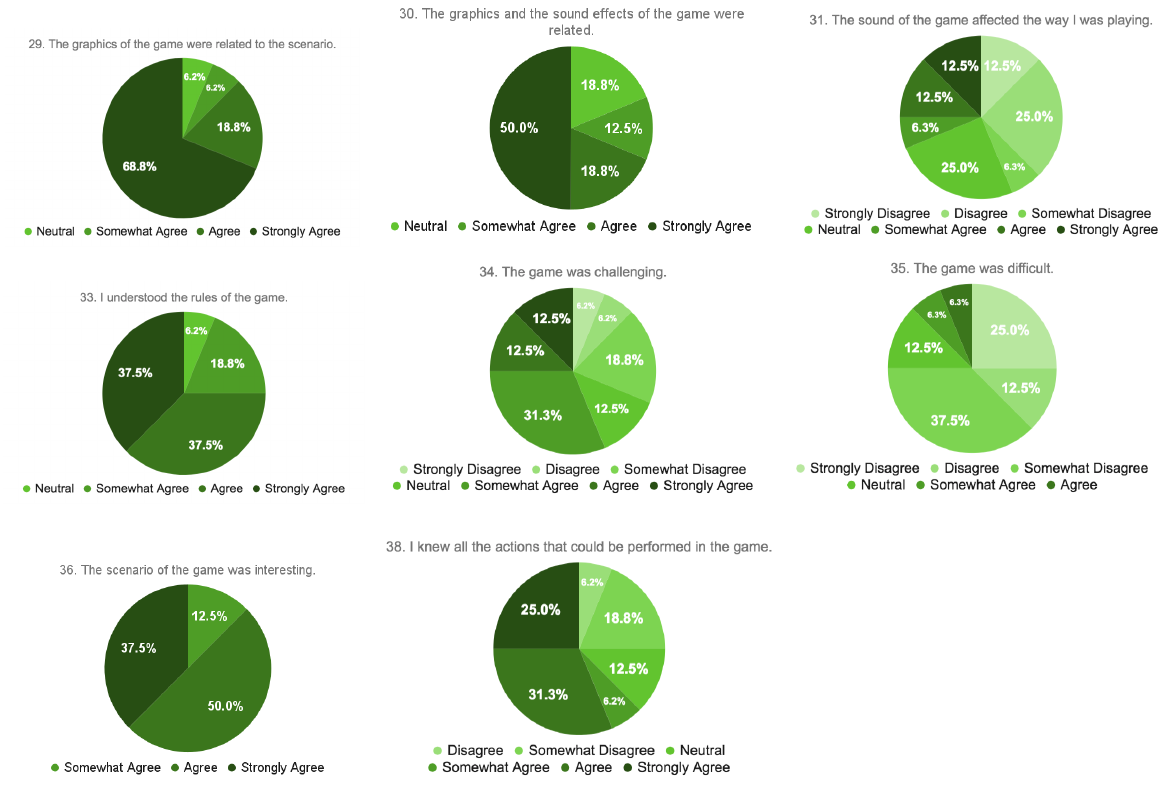
Figure 12. Part II of raw results from the CEGE questionnaire by Calvillo-Gámez et al. (2015), where each question (positively worded) was answered using a 7-point Likert scale